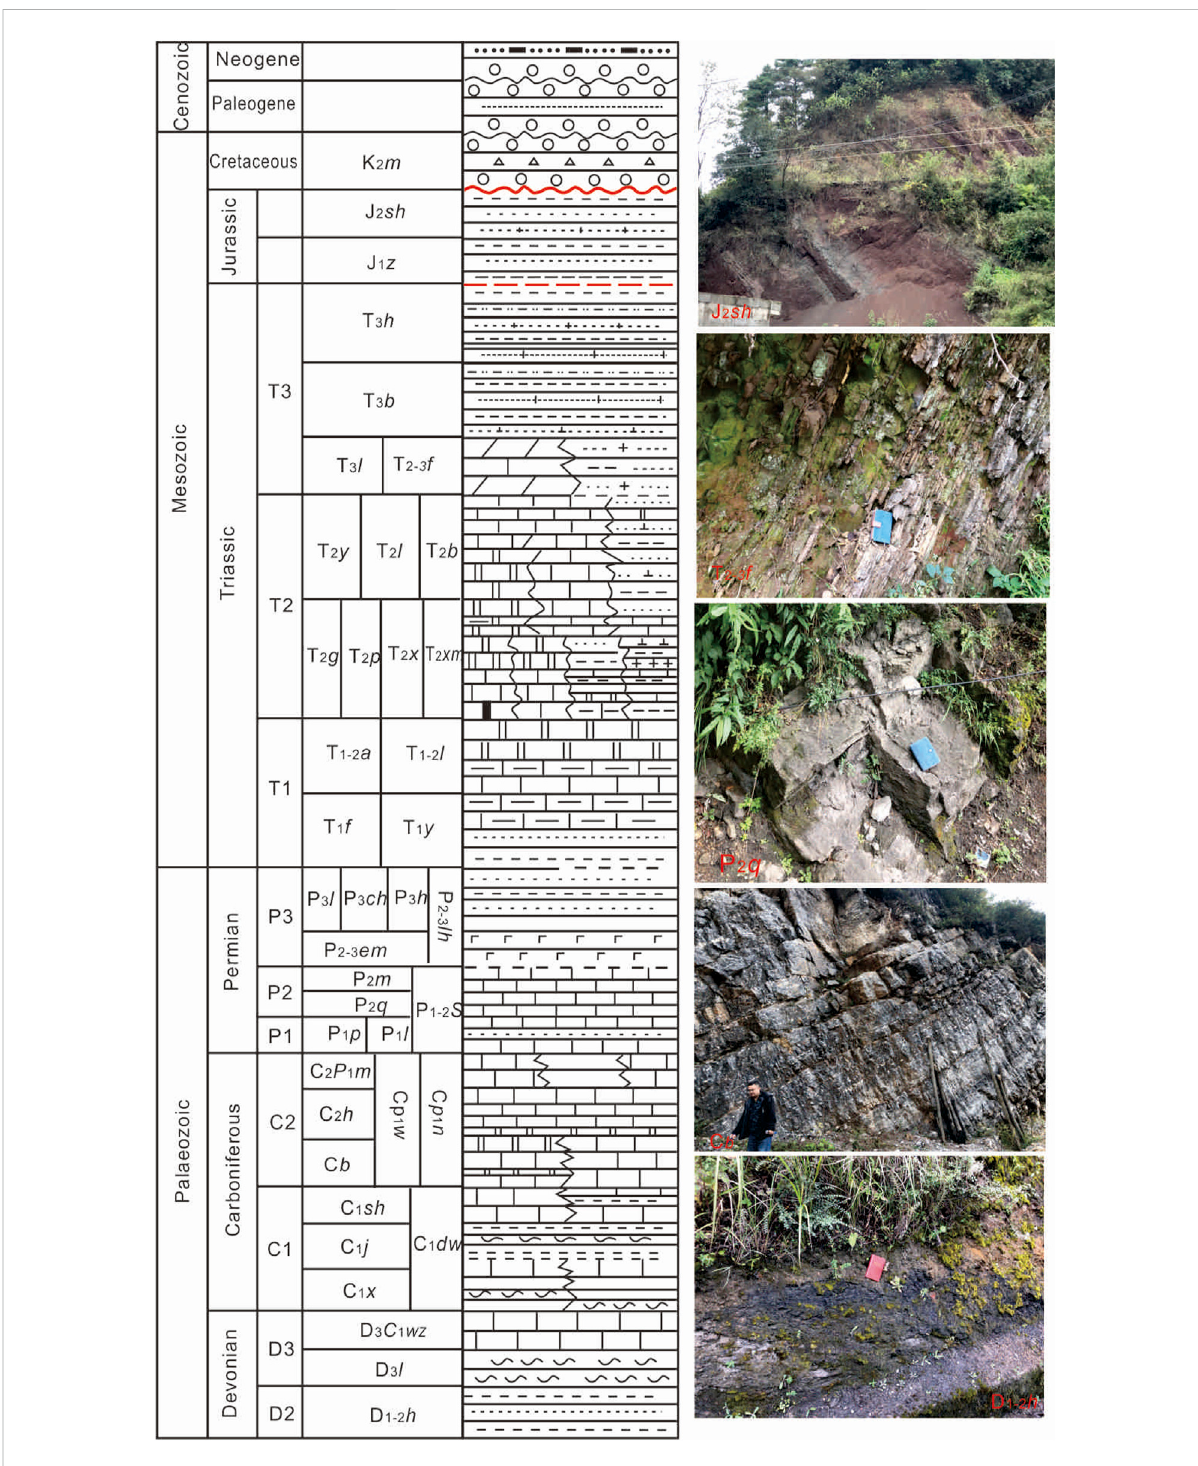
Stratigraphic column and typical photos of rock units outcropped along the Ziyun-Luodian